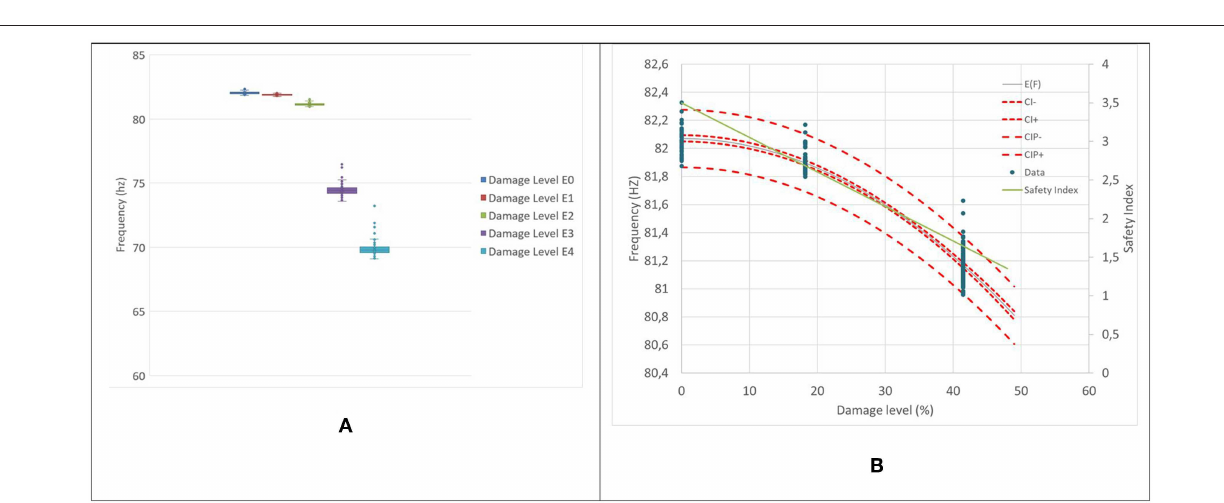
are assumed to follow a normal distribution with a decreasing mean as a function of the level of damage. The results also